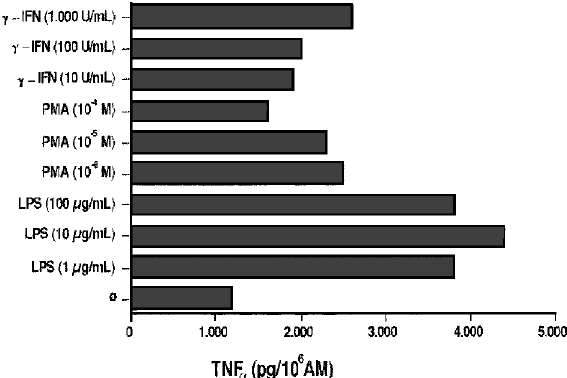
FIG. 1. Effect of concentration and type of stimulus on cytokine secretion by alveolar macrophages (representative case). The most potent stimulus of TNF- a secretion by AM was LPS at a concentration of 10 m g/ml. Definition of abbreviations: AM = alveolar macrophage, IFN = interferon, LPS = lypopolysaccharide, PMA =